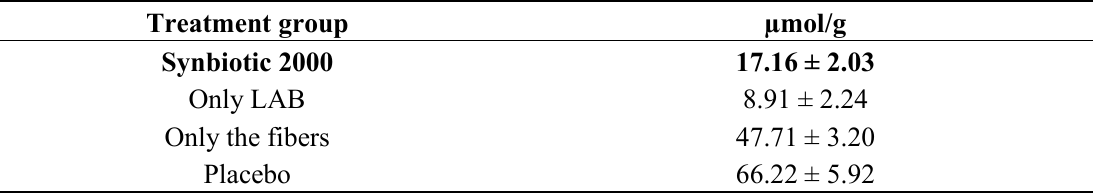
Table 4. Lung tissue nitrite (NO2) and nitrate (NO3), expressed as µmol/g wet tissue, after treatment with Synbiotic 2000, only the LAB in Synbiotic 2000, only the fibers in Synbiotic 2000 and placebo, respectively [71]; p <